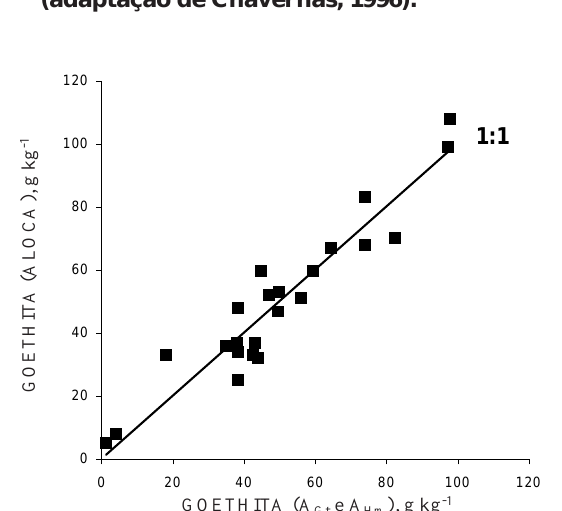
Figura 8. Relação entre o teor estimado de goethita por análises químicas e difratometria de raios- X e o calculado a partir de A Quadro 6), com indicação da reta correspon- dente à igualdade de valores (x = y).